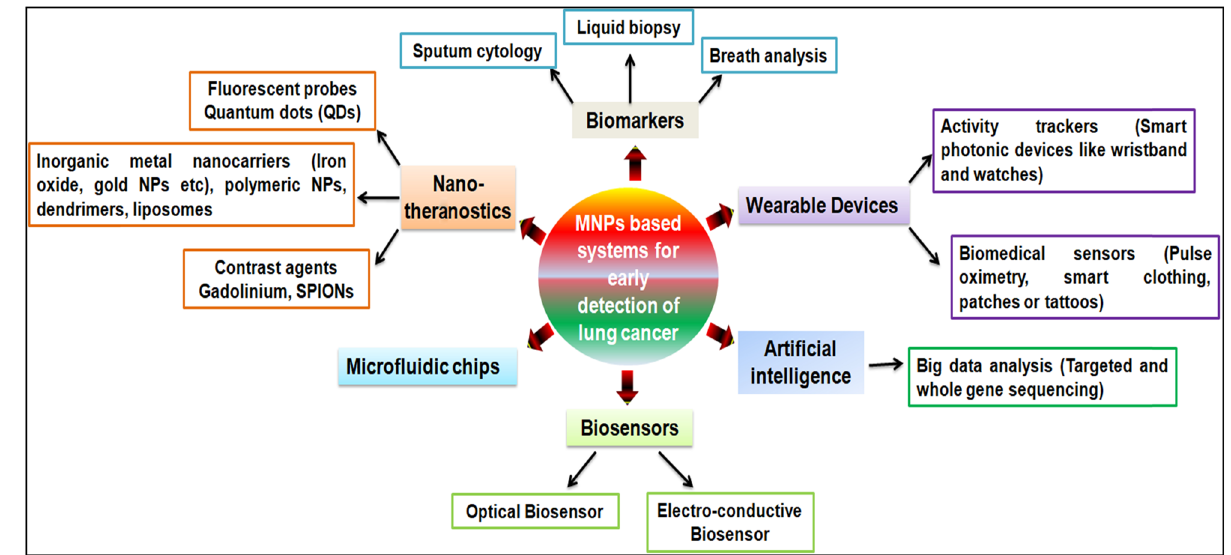
Figure 4: Advanced diagnostic tools for early detection of LC.